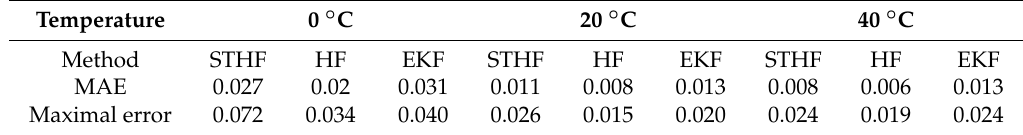
Table 6. Mean absolute errors (MAEs) and maximal errors of STHF, HF and